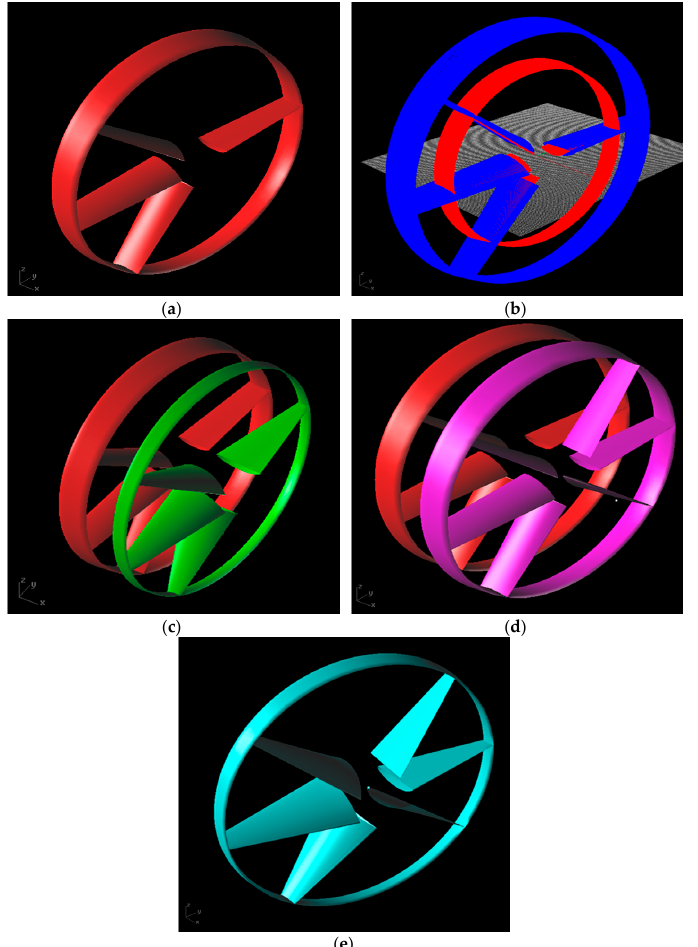
Figure 12. Configurations of parametric design of ring stator: ( a ) Case 1; ( b ) Case 2; ( c ) Case 3; ( d ) Case 4; ( e ) Case 5